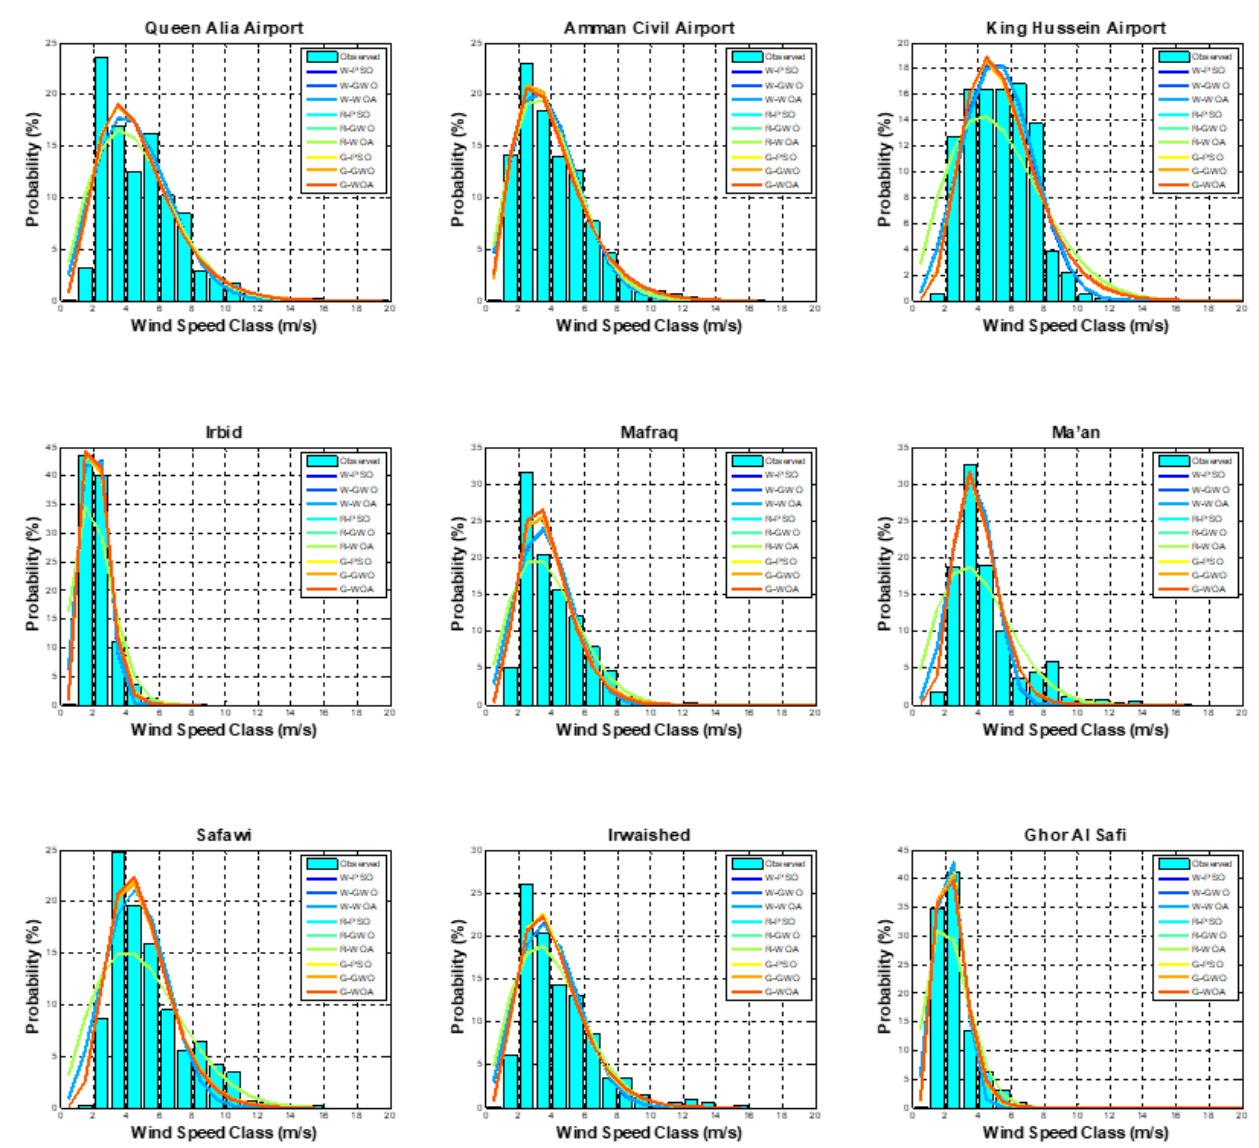
Figure 6. Probability distribution function for the selected sites.